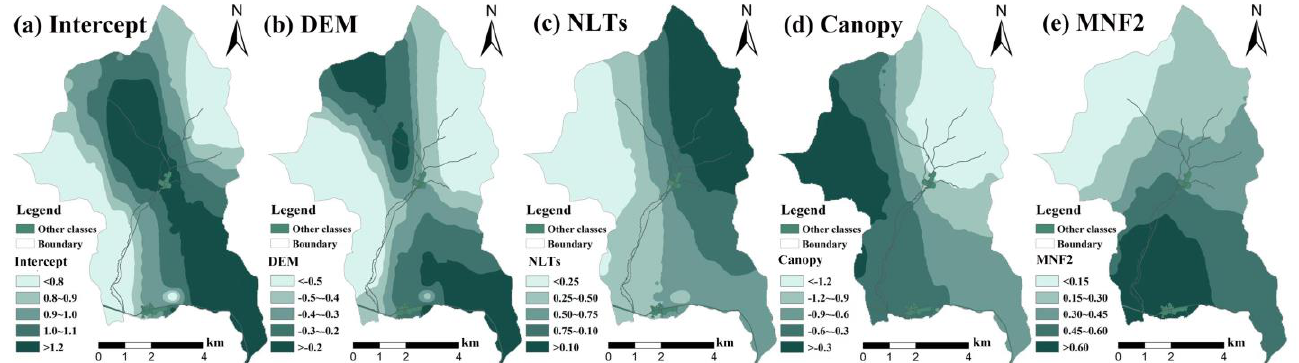
Figure 7. Coefficient visualization analysis of the SGWPR local variables: ( a ) intercept, ( b ) DEM, ( c ) NLTs, ( d ) canopy, and ( e ) MNF2. Note: IPVI represents the Infrared Percentage vegetation index, MeanB8 represents the B8 mean textural feature analysis, MNF2 represents the second minimum noise fraction (MNF) of sentinel 2, PR represents the Poisson regression, LMPR represents the Liner mixed PR, GWPR represents the Geographically weighted PR, SGWPR represents the semiparametric GWPR.